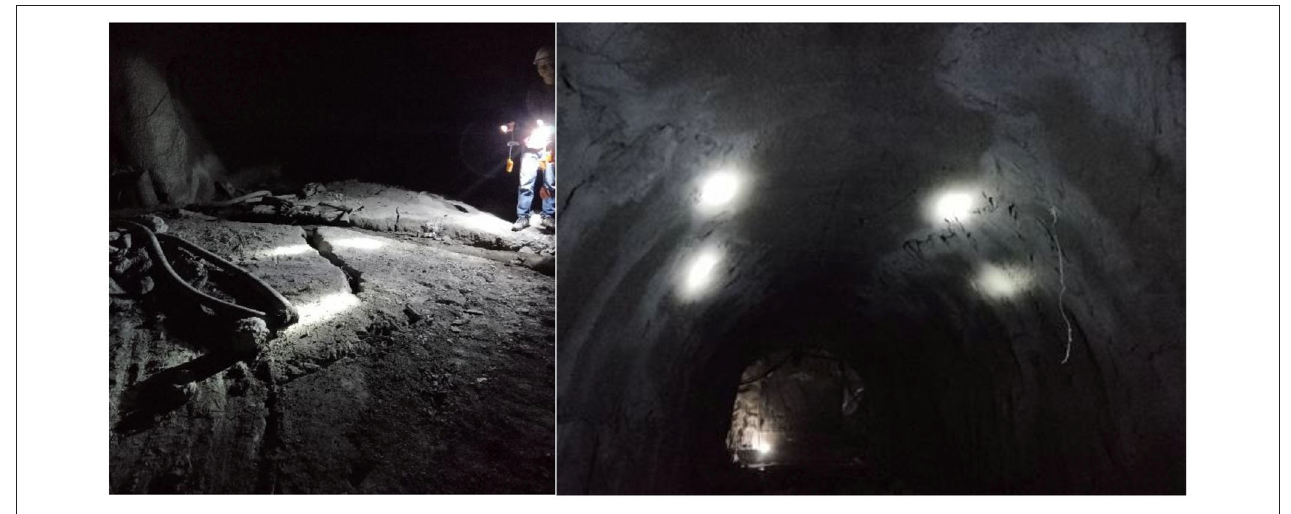
FIGURE 3 | Deformation sign of support.